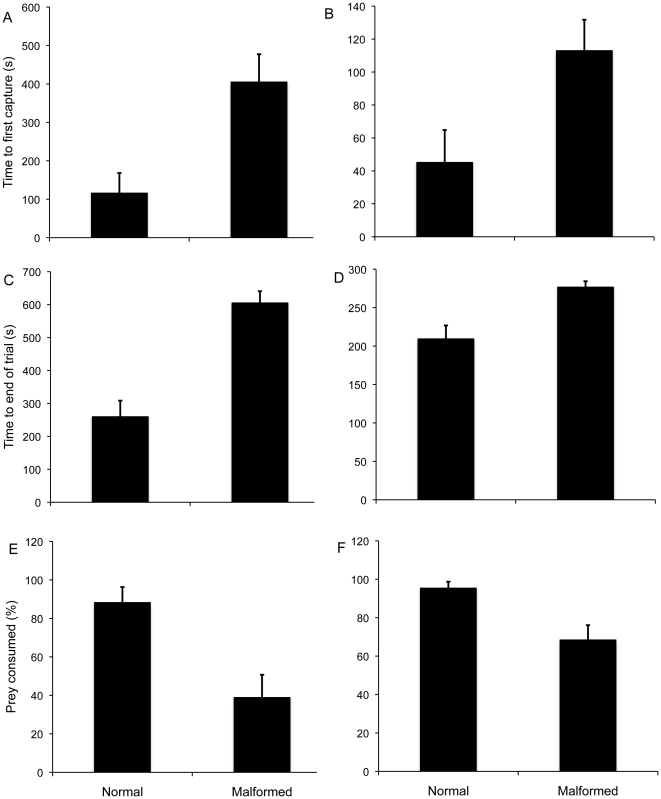
Effects of limb malformations on the prey capture ability of Pacific chorus frogs (P. regilla) in laboratory trials.Presented are the results of trials measuring the time required to first capture a single small cricket (A) or fruit fly (B), the time until all prey items were consumed or the trial was ended for crickets (C) or fruit flies (D), and the total proportion of prey consumed by the end of the trials for crickets (E) or fruit flies (F). Frogs were presented with either a single cricket or 5 fruit flies and allowed a maximum of 720 s and 300 s, respectively, to consume all prey before the trial was ended.